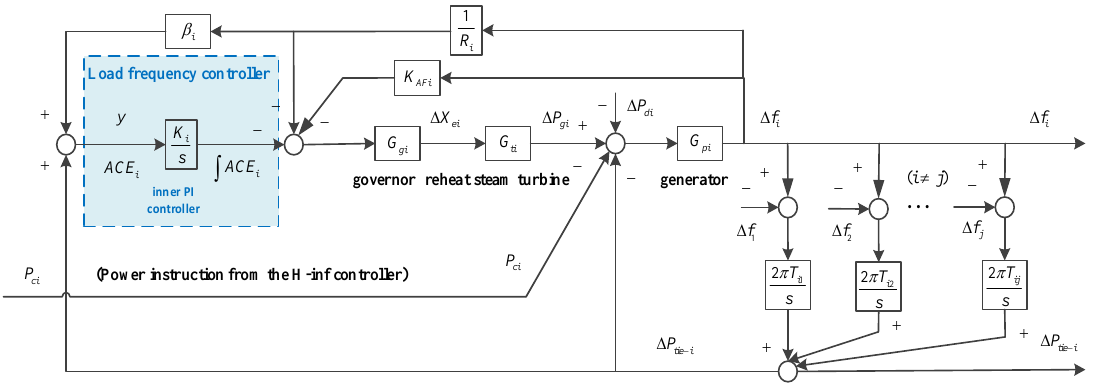
Figure 2. Linearization model structure of the system in i th control area.